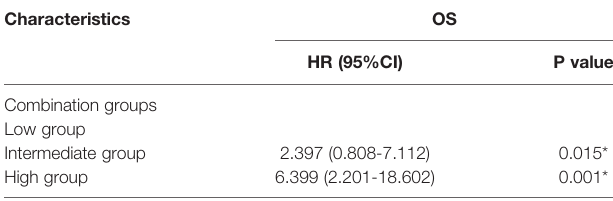
TABLE 5 | Multivariate analysis of overall survival in all